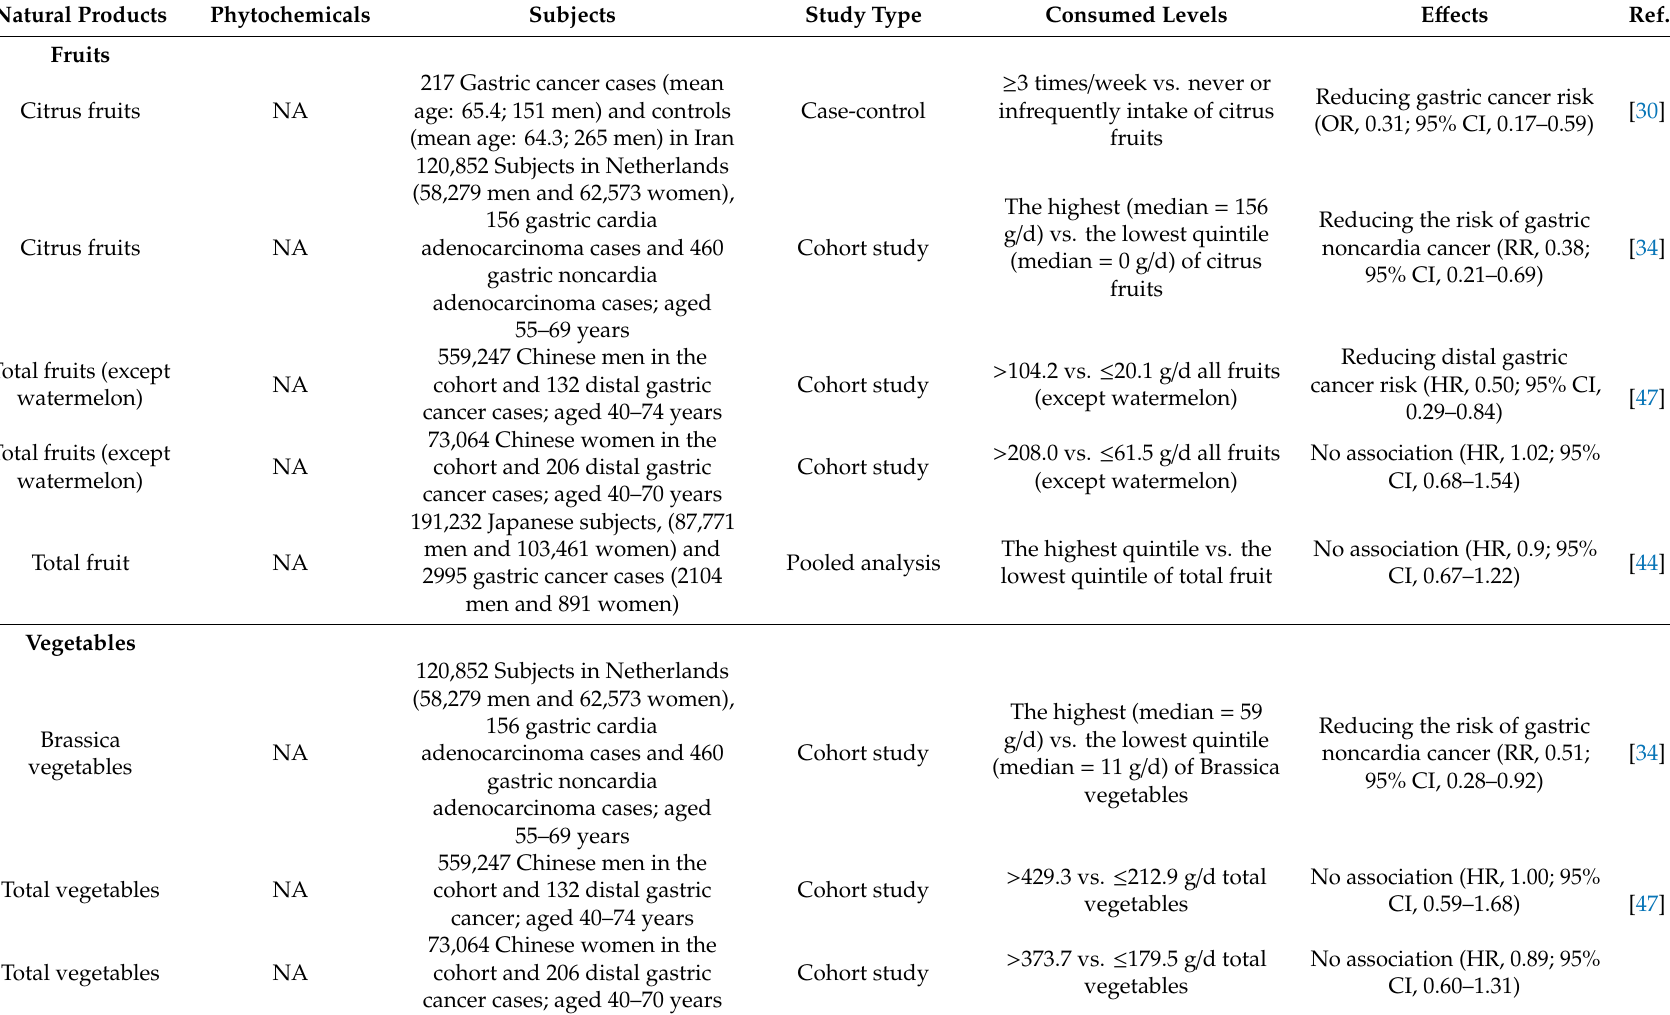
Table 1. The e ff ects of natural dietary products against gastric cancer from epidemiological